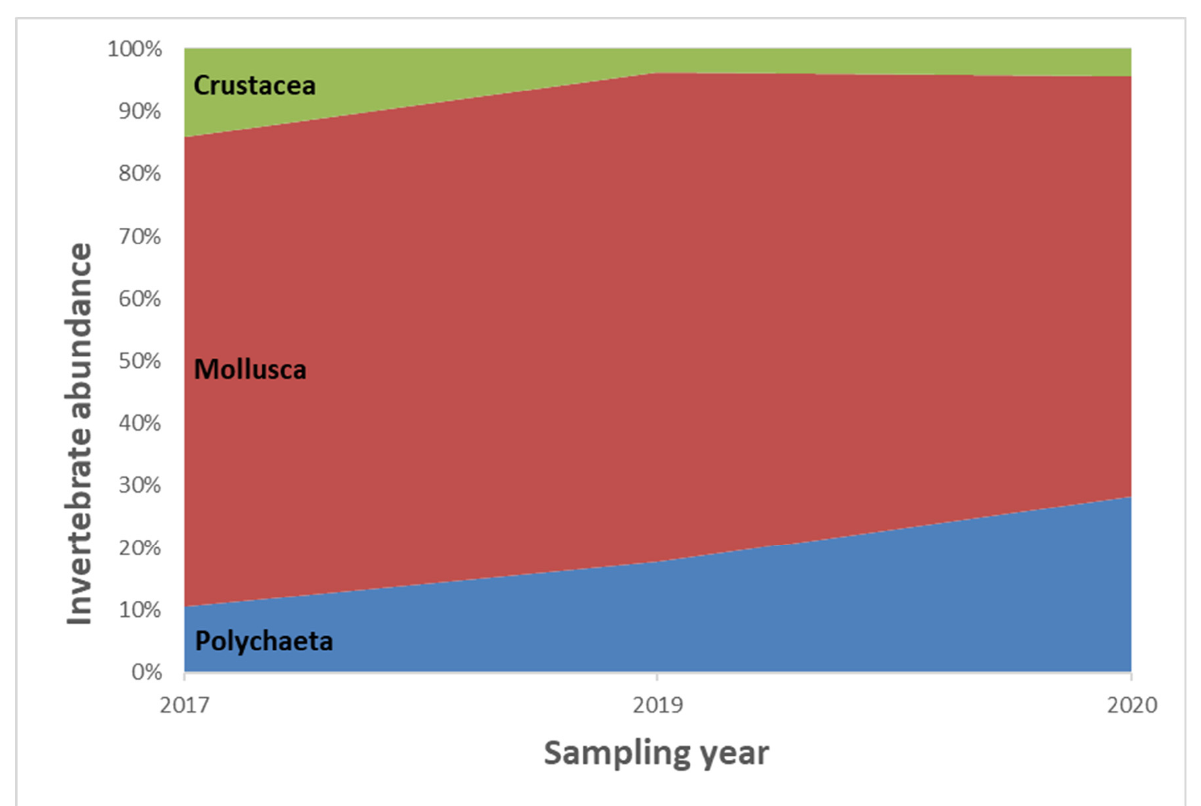
Figure 5. Relative abundance (%) of the major motile invertebrate taxonomic groups per year. Colors indicate different major taxonomic groups of the invertebrates identified from the scrapes of the MANOSS sampler.